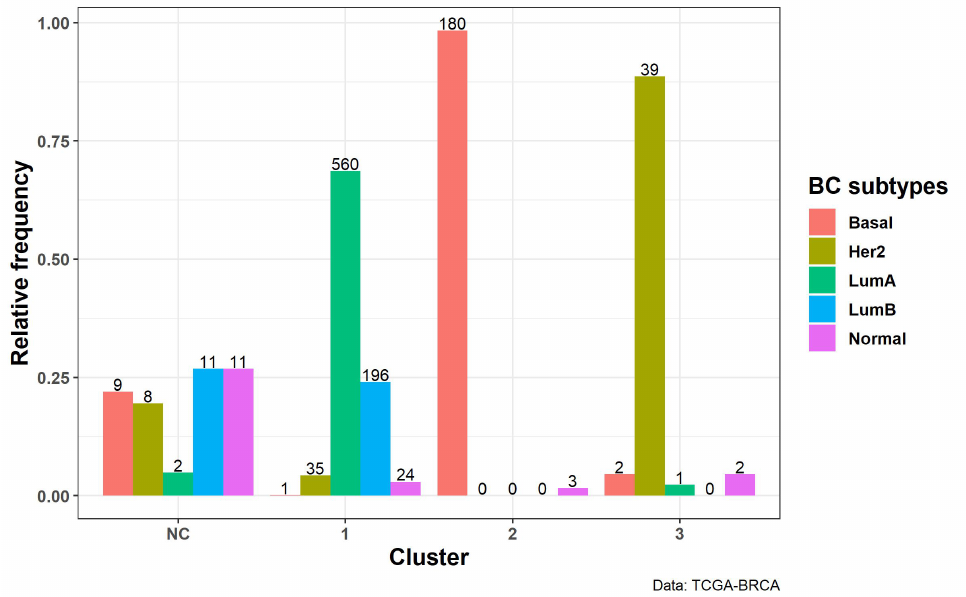
Figure 6. BC subtype distribution over estimated clusters. Relative (vertical axis) and absolute (top of the bars) frequency of BC subtypes within each cluster, identified on spherical UMAP embedding with NN = 65. On the horizontal axis, we report the cluster labels. NC stands for Not Clusterable (see Methods